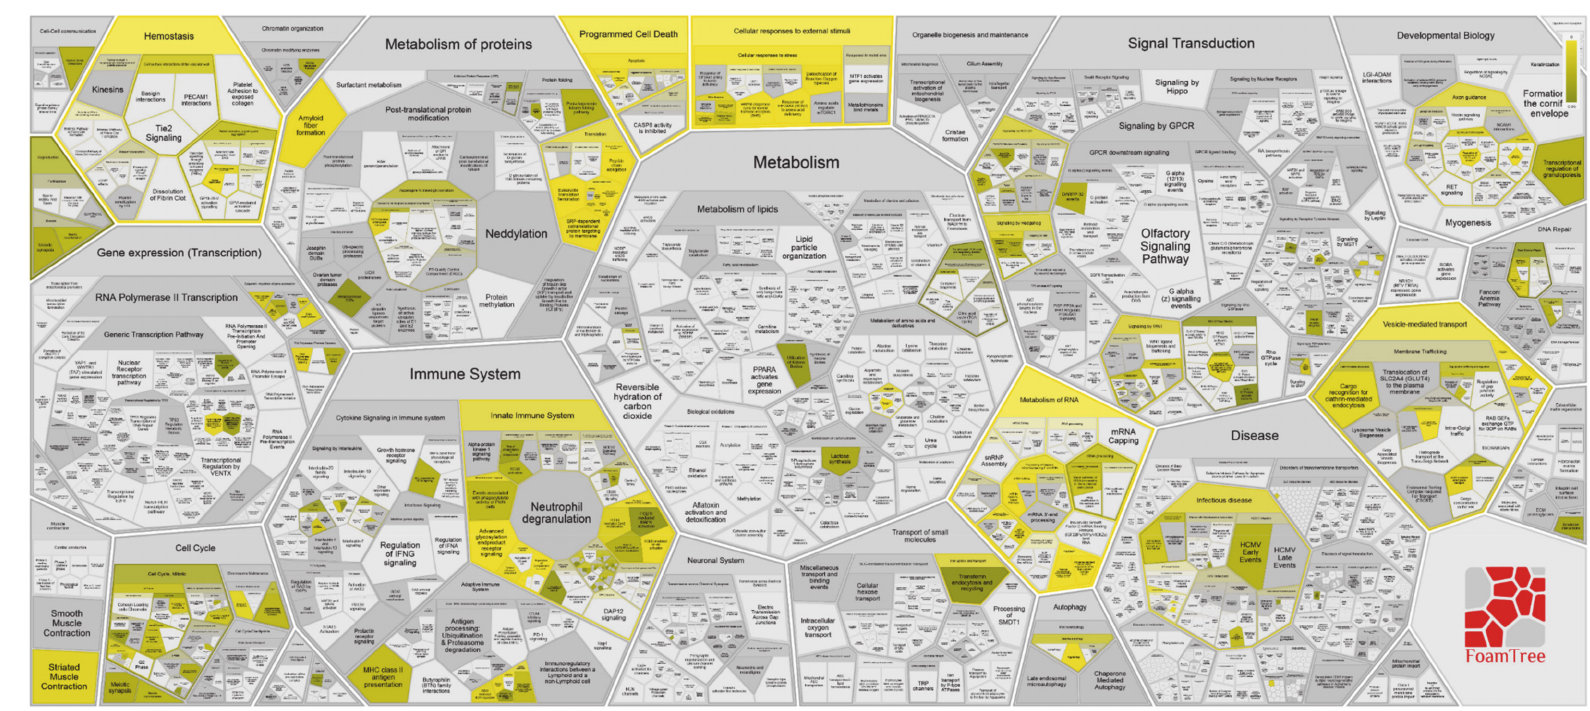
Figure 10. Voronoi diagram representation of the hierarchical pathways overrepresentation analysis by Reactome of the protein elements identified in the R GBM tumor